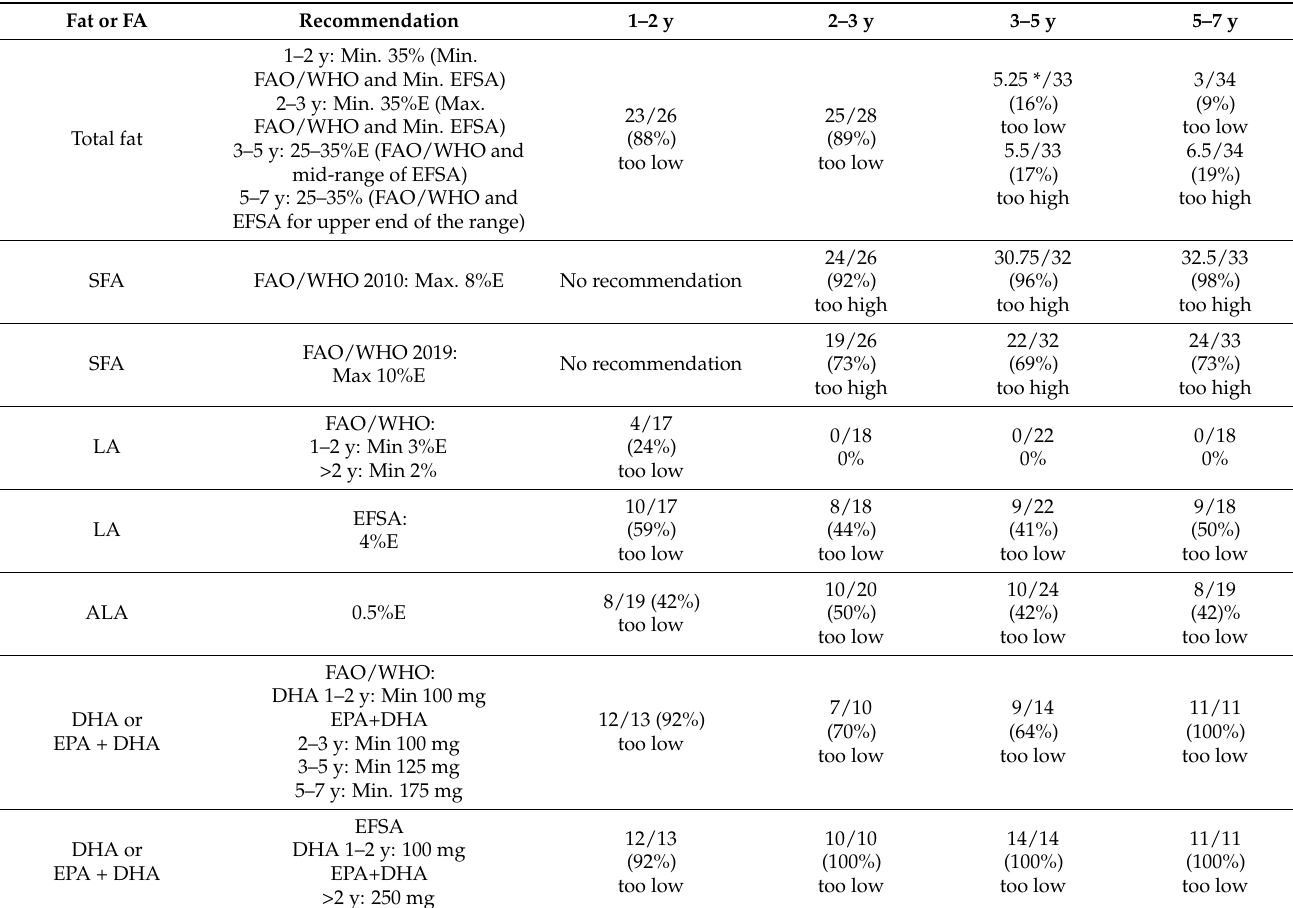
Table 3. Recommended cut-off values and summary of the evaluation against the recommendation (values are: number of studies not in line with recommendations/total number of studies and % studies not in line with